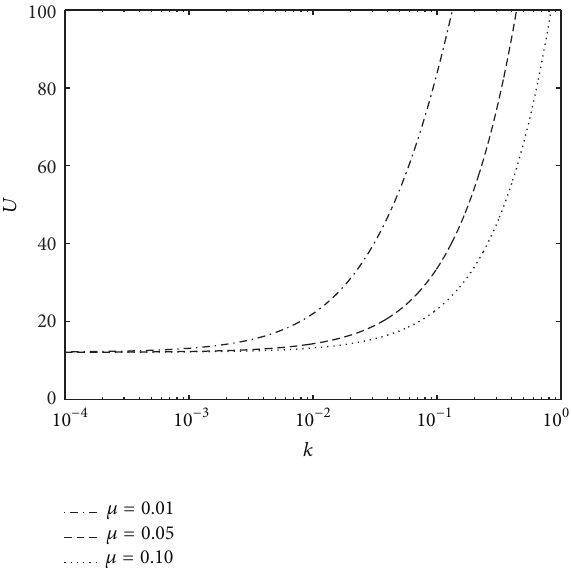
Figure 3: The neutral curves of velocity ratio for the different values of viscosity ratio of two fluids when 𝐸 = 5 , 𝑊 = 100 , 𝜌 = 0.0012 .